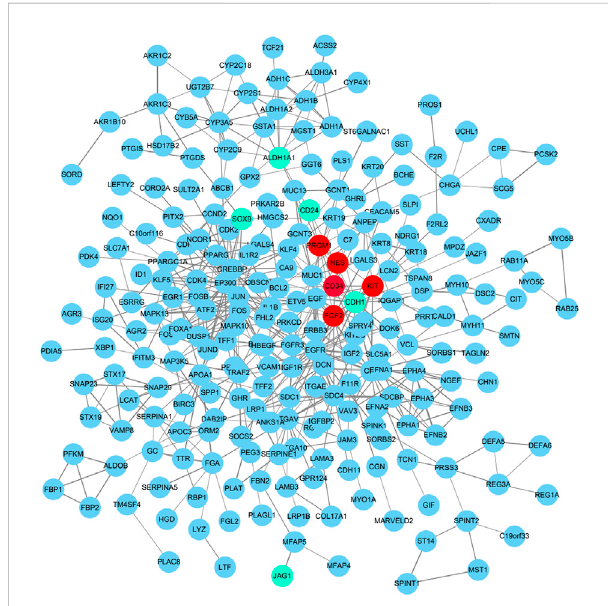
FIGURE 6 Protein – proteininteractionnetworkof188upregulatedgenesand 305 downregulated genes were analyzed using Cytoscape software. The edges between 2 nodes represent the gene-gene interactions. Upregulated hub genes in red, downregulated hub genes in teal.